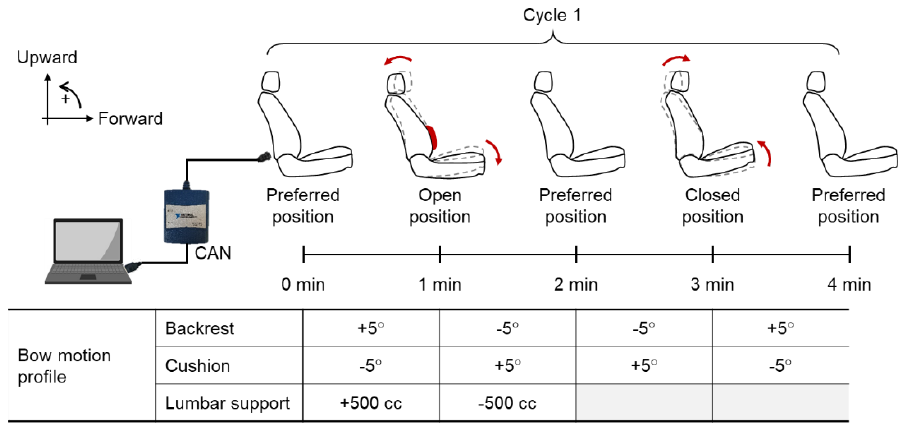
Figure 2. Designated seat motion profile of backrest recline, cushion tilt, and lumbar support inflation/deflation.